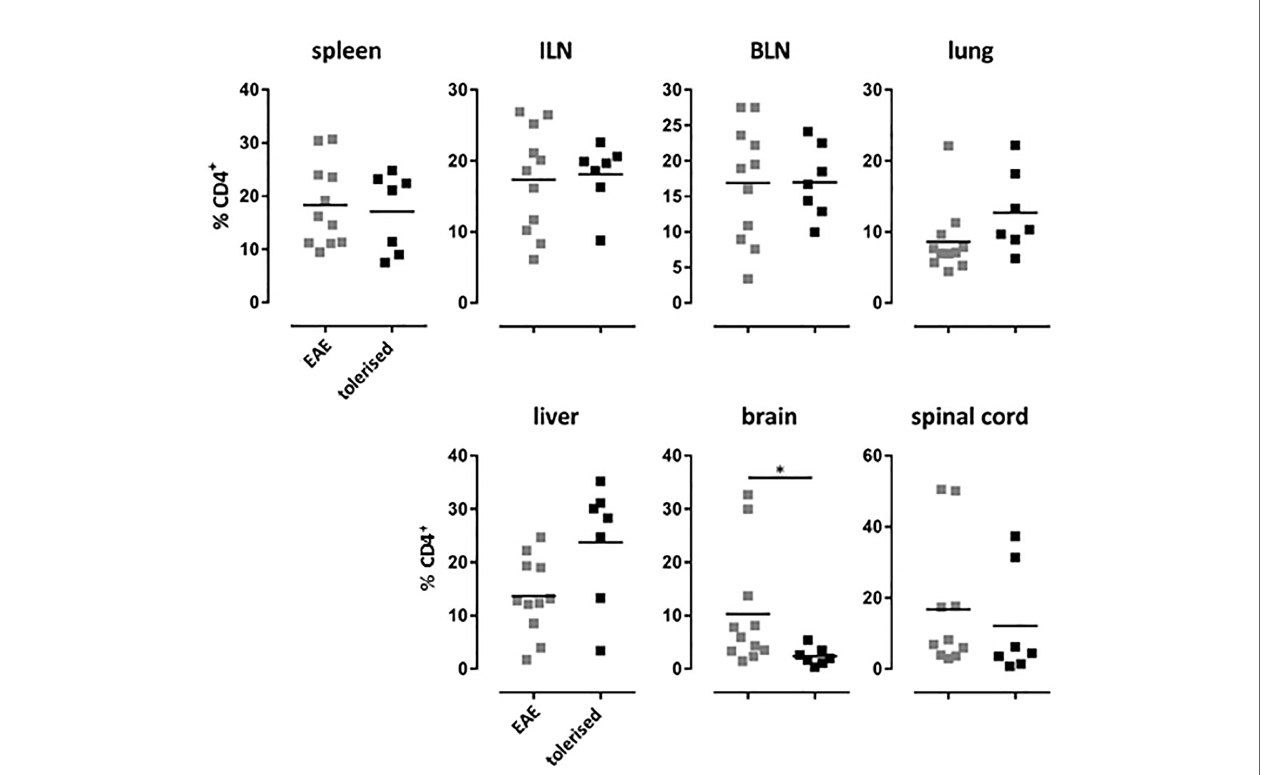
FIGURE 7 | Distribution of CD4 + T cells in EAE after tolerization. Tg4 mice were treated with PBS or 4Y by dose escalation ( Figure 5A ) before the induction of EAE with their cognate peptide in CFA, and pertussis toxin given on days 0 and 2. Animals were analyzed at the peak of disease when mice treated with PBS showed complete hind limb paralysis (grade 3) and EDI-treated animals showed no sign of disease. Gated on single cells. Horizontal lines indicate mean (*p ≤ 0.05, **p ≤ 0.01, ***p ≤ 0.001, ****p ≤ 0.0001). Each dot represents one